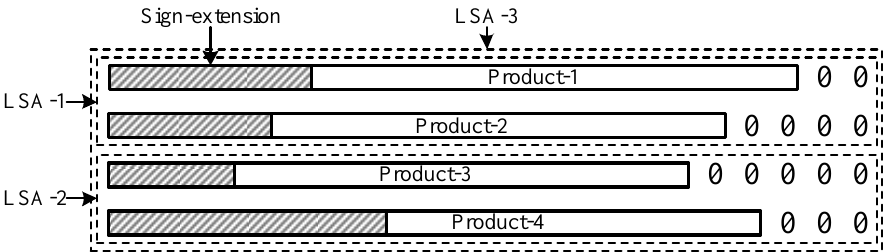
Figure 4. Bit-level complexity of